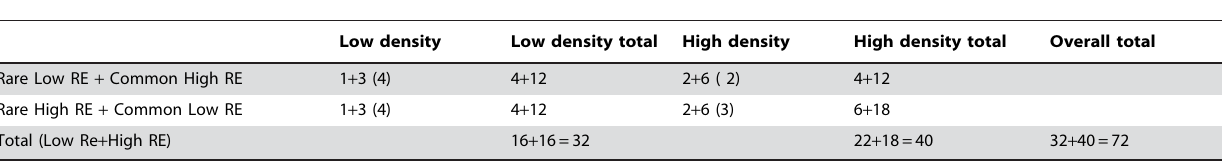
Table 4. The design of the